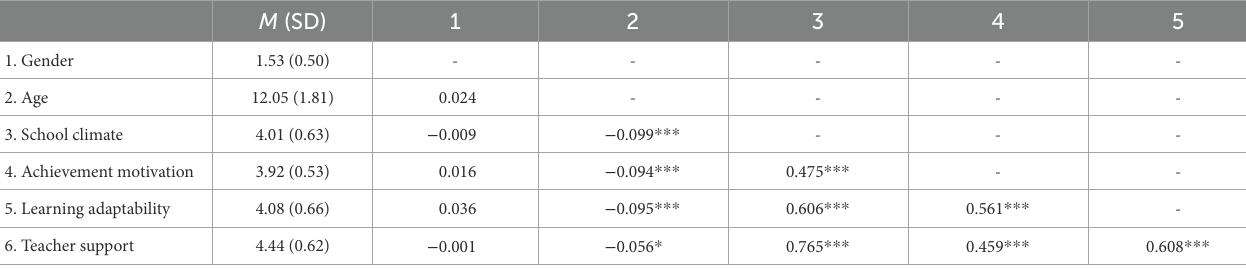
TABLE 1 Means, standard deviations, and correlations among